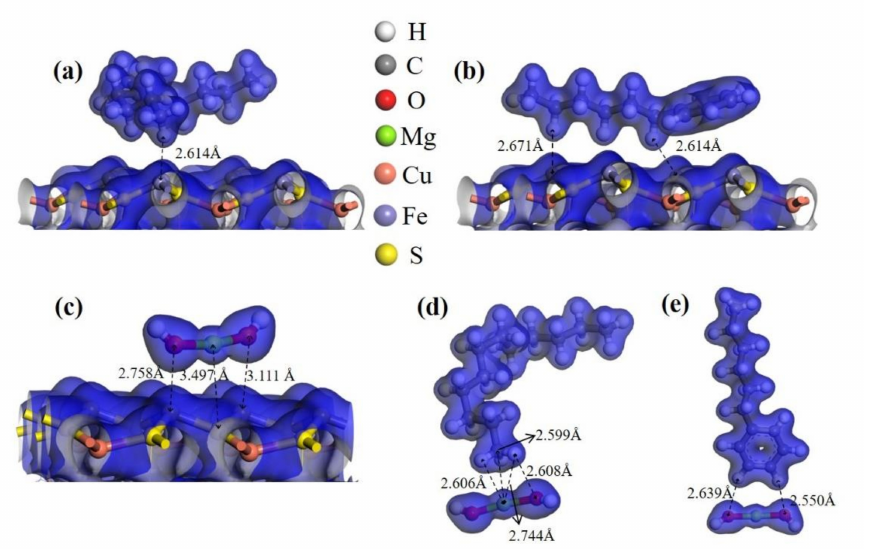
Figure 9. Electron density of ( a ) straight-chain paraffin, ( b ) straight-chain aromatic hydrocarbon, and ( c ) Mg(OH) 2 adsorbed on the chalcopyrite (112) surface; and electron density of ( d ) straight-chain paraffin and ( e ) straight-chain aromatic hydrocarbon on Mg(OH) 2 .